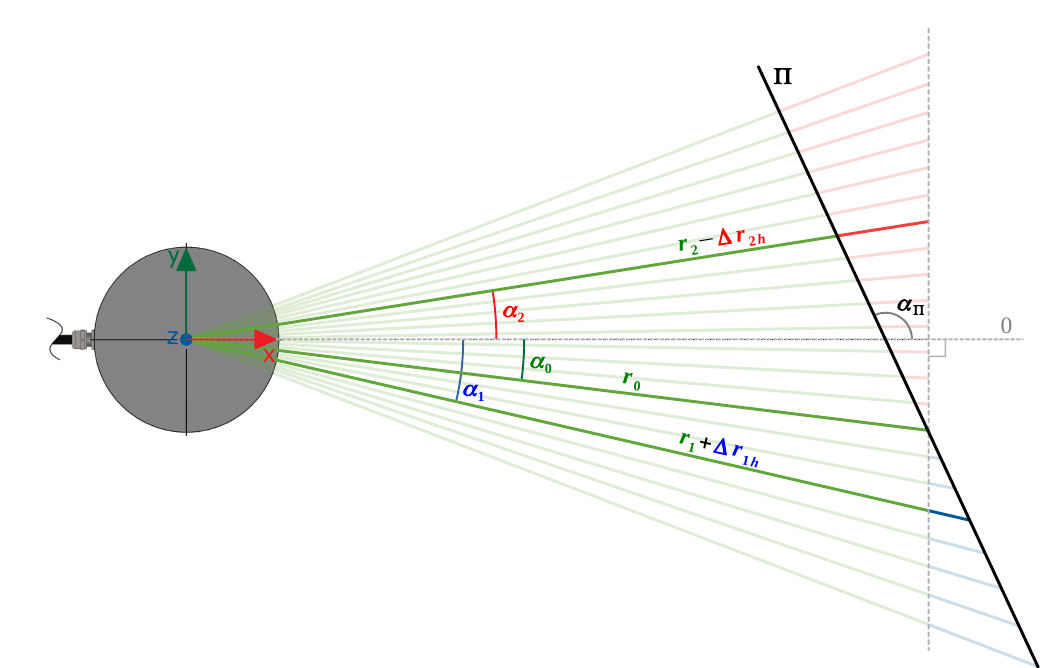
Figure 7. Horizontal measurements of a